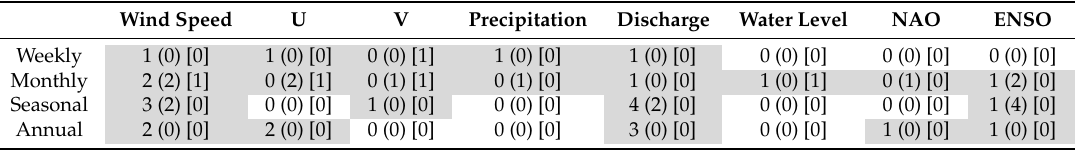
Table 4. The number of estuaries (0–11) for which each variable was identified as a significant driver (R 2 adj > 0.2, p < 0.05) of turbidity time-series, 90th percentile events (in parentheses), and 95th percentile events [in brackets] for each time step. Positive results shaded